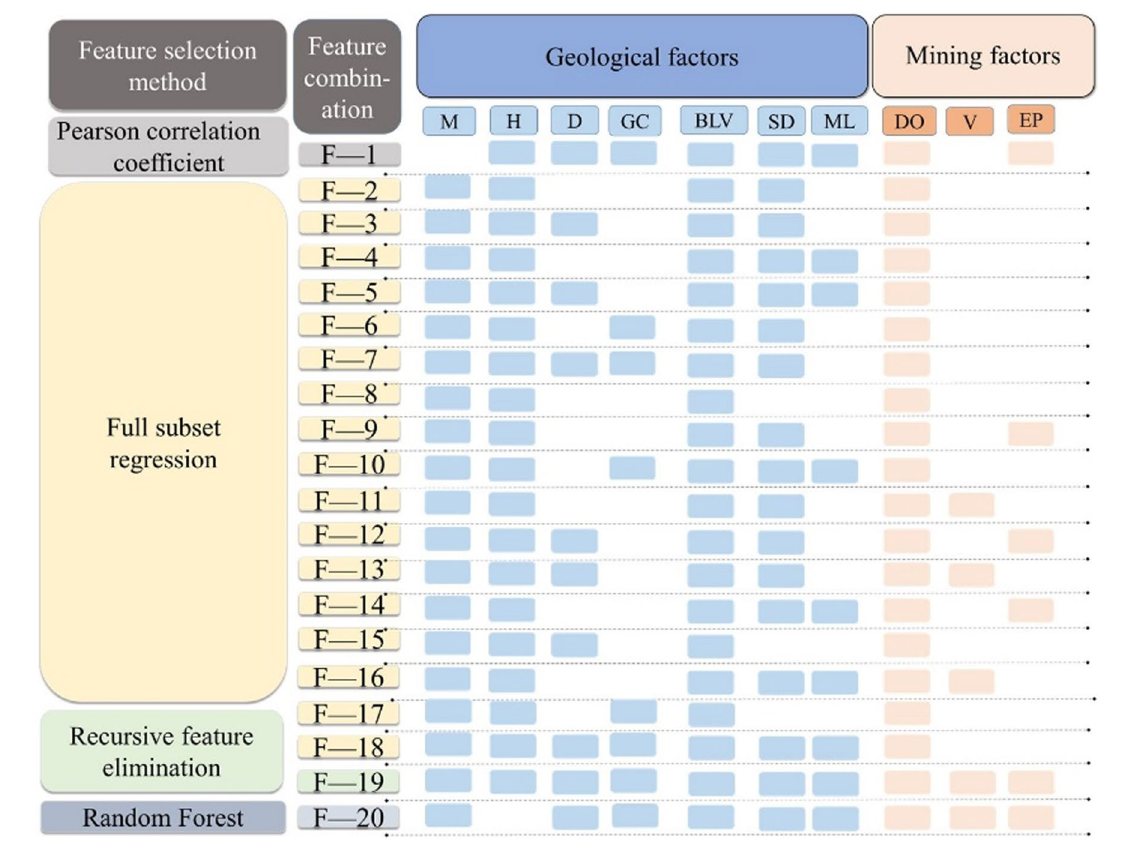
Fig. 4 Combination set of feature parameters affecting gas emission. Notes : F-1 represents the first feature combination, F-2 represents the second feature combination, and so on. The feature combination of the same color is selected by the corresponding feature selection method on the